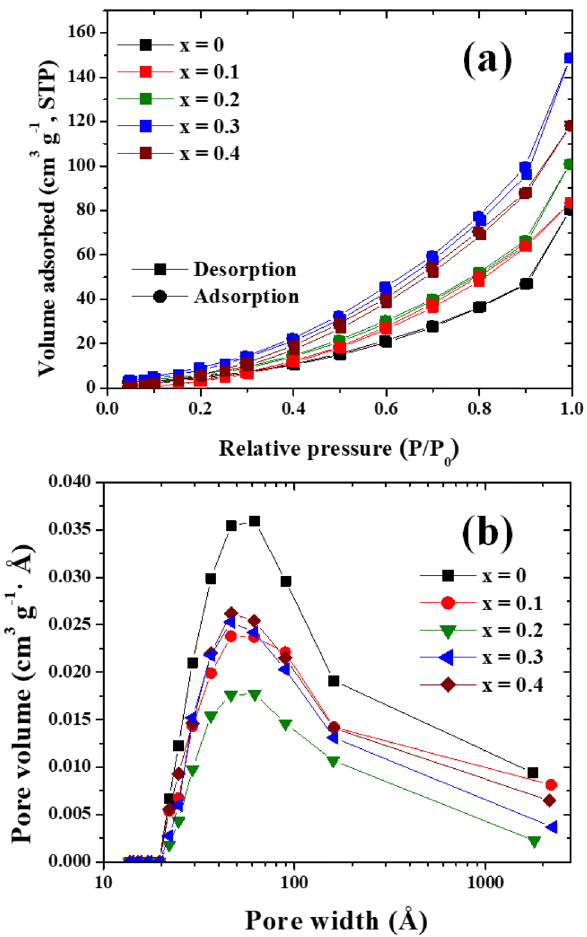
Figure 9. ( a ) BET isotherm, ( b ) pore size distribution curves of Co x Zn 1−x Fe 2 O 4 (x = 0.0–0.4)